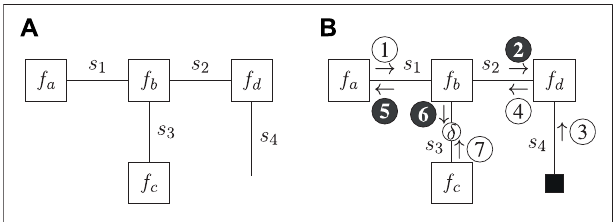
FIGURE 1 | Forney-style factor graph representation for the example model of ( Eq. 29 ) (A) and message passing schedule for the Bethe Free Energy minimization of (Eq. 30 ) (B) . Shaded messages indicate variational message updates, and the solid square node indicates given (clamped) values. The round node indicates a point-mass constraint for which the value is